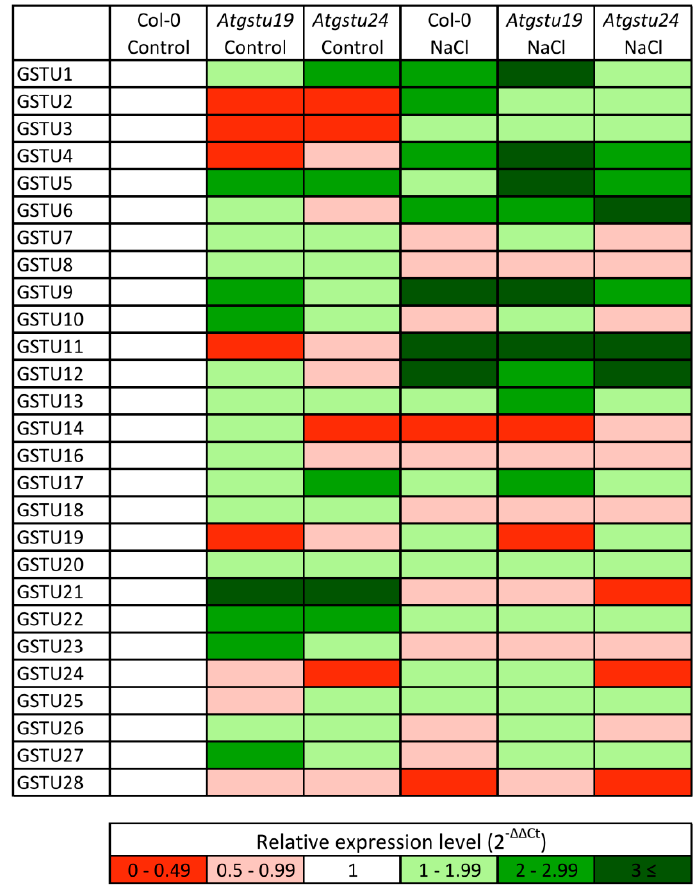
Figure 2. Heat map of 27 A. thaliana tau group glutathione transferase ( GSTU ) gene expression levels. Relative transcript amounts of GSTU genes were determined by RT-qPCR under control conditions (Control) and after 150 mM NaCl treatment (NaCl) in wild-type (Col-0) and GSTU mutant ( Atgstu19 and Atgstu24 ) Arabidopsis plants. For this, the expression of GST genes was normalized first by reference to the average transcript amount of GAPDH2 and actin2 genes, and second to the average transcript amount of each GST genes in wild-type control plants. 2 - ∆∆ Ct data were presented as a heat map. Red colours show repression, while green colours show activation, according to the colour scale bar. The presented data are from one biological